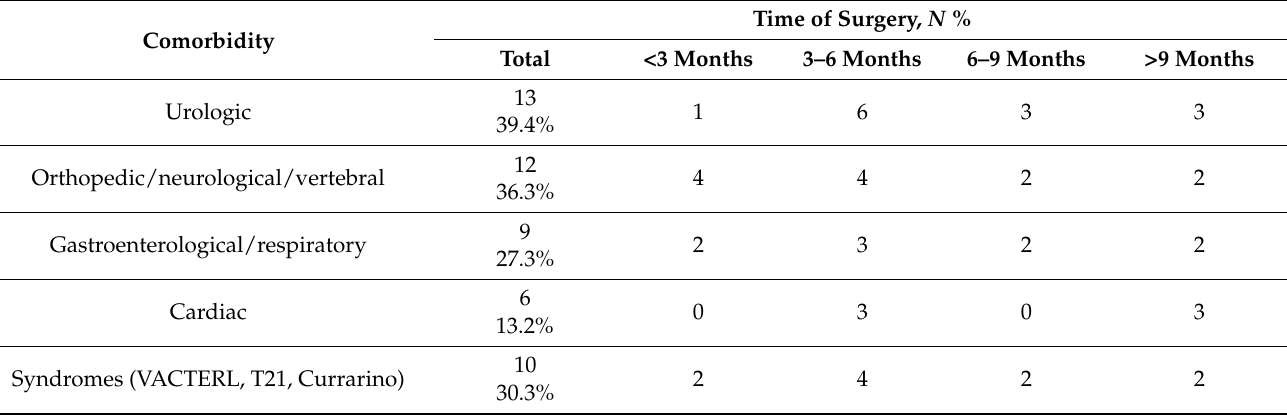
Table 1. Associated comorbidities and relative percentages on affected patients, classified according to age at time of